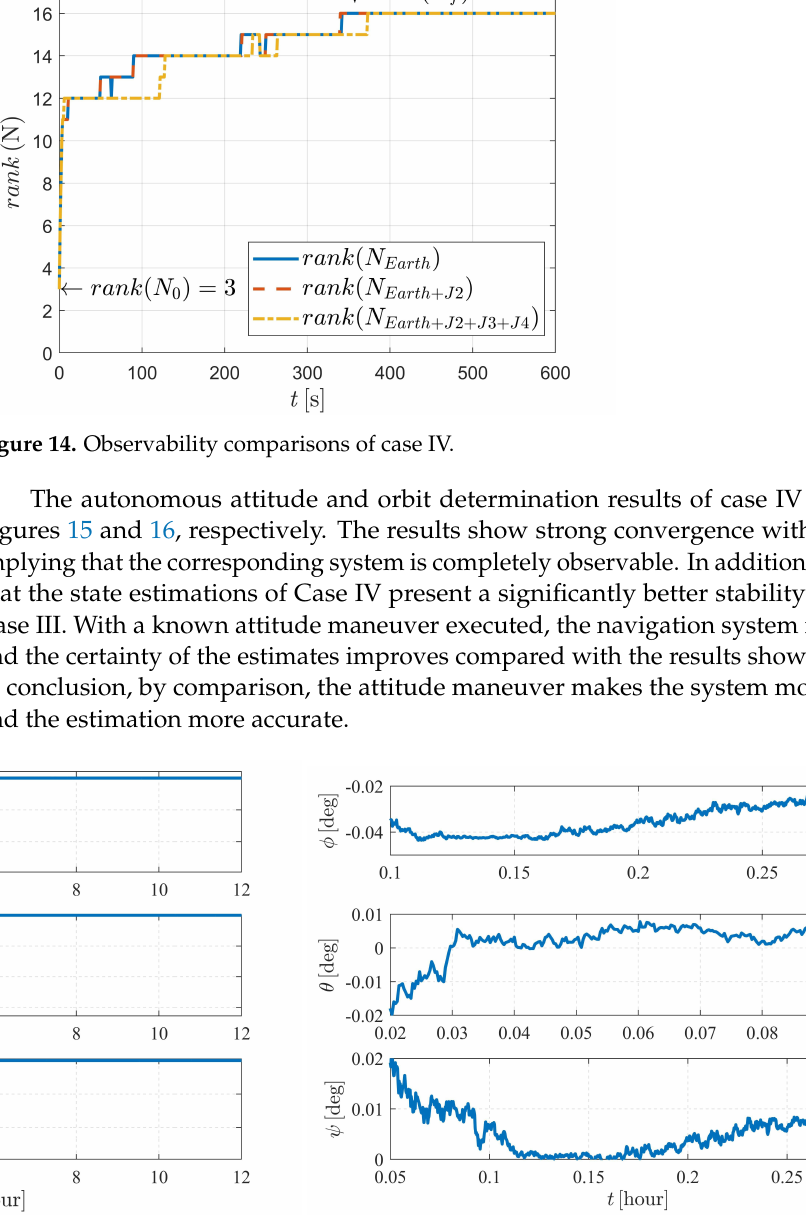
Figure 15. Attitude determination errors of case IV (nonperturbation) and the corresponding larger